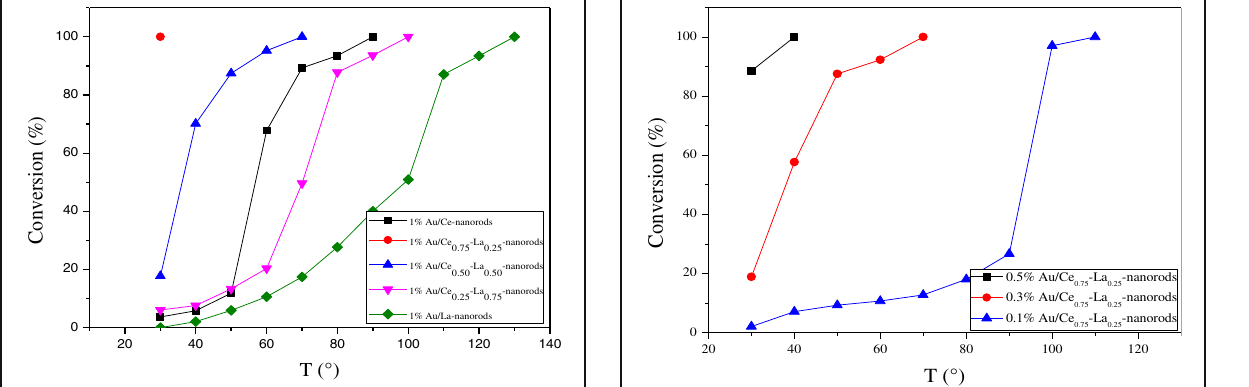
Fig. 10 Catalytic activities of Au/Ce 0.75 -La 0.25 nanorods with different gold goadings calcined at 300 °C for 2